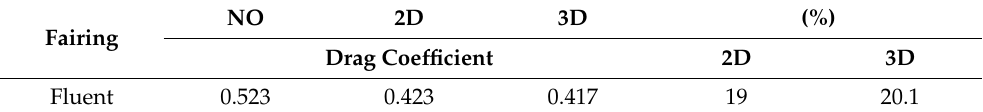
Table 5. Drag coefficient data. Table 5. Drag coe ffi cient data.